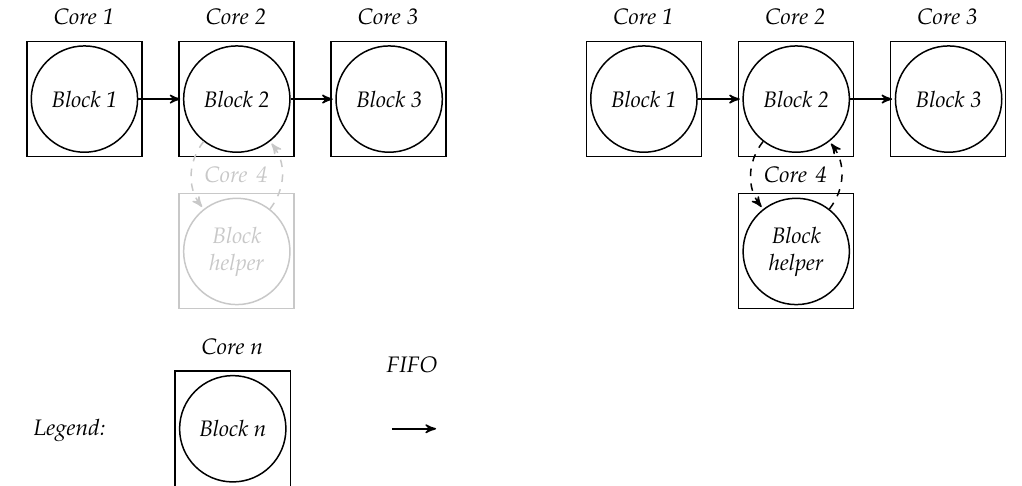
Figure 8. Subdivision of the workload given by the blocks into several